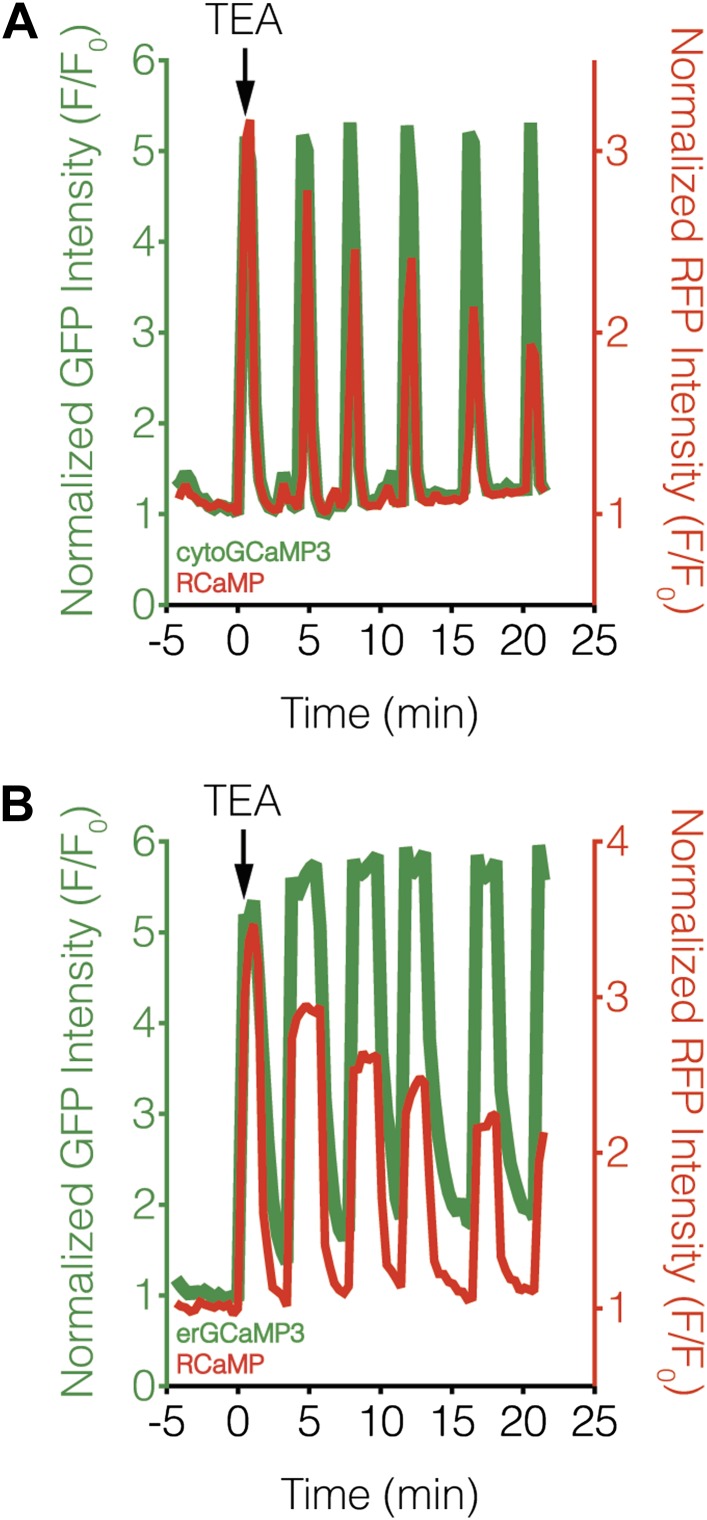
Subcellular Ca2+ dynamics match global Ca2+ dynamics in MIN6 cells.Representative curves showing the response from (A) cytoGCaMP3 (n = 23) or (B) erGCaMP3 (n = 38) (green curves) and RCaMP (red curves) in MIN6 cells treated with 20 mM TEA. (A) To compare the Ca2+ dynamics in different subcellular compartments in MIN6 cells, GCaMP3 and RCaMP were first co-expressed in the cytosol. TEA stimulation induced completely overlapping responses from both probes, indicating that they have similar properties, though the RCaMP response amplitude often decreased over time. (B) GCaMP3 was then targeted to the ER surface while RCaMP was kept in the cytosol. Upon TEA stimulation, the GCaMP3 response again tracked closely with the RCaMP response, with no noticeable differences in the timing of Ca2+ increases or decreases between the ER and cytosol. The basal GCaMP response drifted upwards at the ER surface, but this did not affect the overall dynamics of the Ca2+ oscillations.